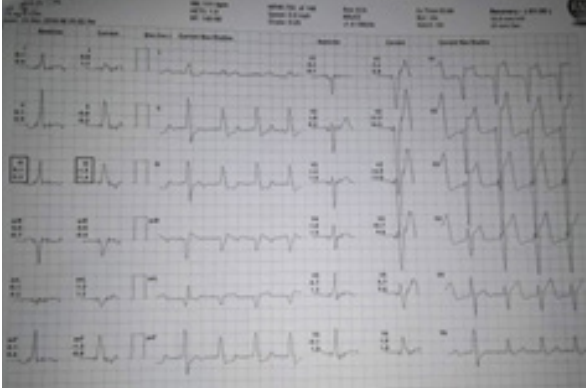
Figure 2: Electrocardiogram showing persistence of LBBB for over 1 minute into recovery with a decrease in QRS width from 120ms during peak exercise to 80ms at 92b/min. Because of the ECG changes on TMT, Coronary Angiogram (CAG) was undertaken which revealed a 70% stenosis in the first diagonal branch of Left Anterior Descending Artery (LAD) and a 40% lesion in proximal Right Coronary Artery (RCA) with minor plaques in mid LAD and Left Circumflex artery (LCx). She was planned for conservative management for her CAD and underwent exploratory laparotomy with intraoperative beta- blocker and nitroglycerine to control her HR and BP. The post- operative period remained uneventful and the patient was started on a regimen of antiplatelet, statins, and beta-blockers after she regained her bowel